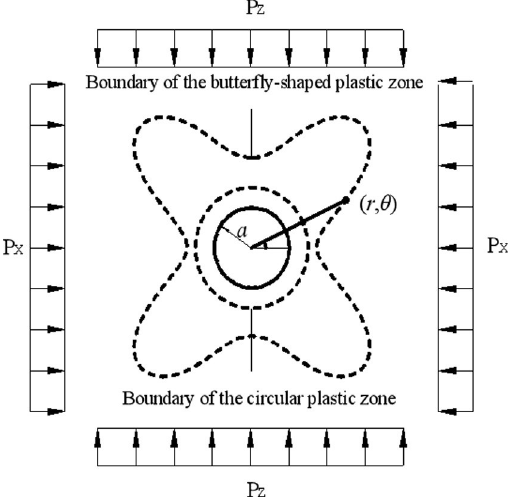
Fig 2. Stresses on rocks surrounding a circular hole and boundaries of plastic